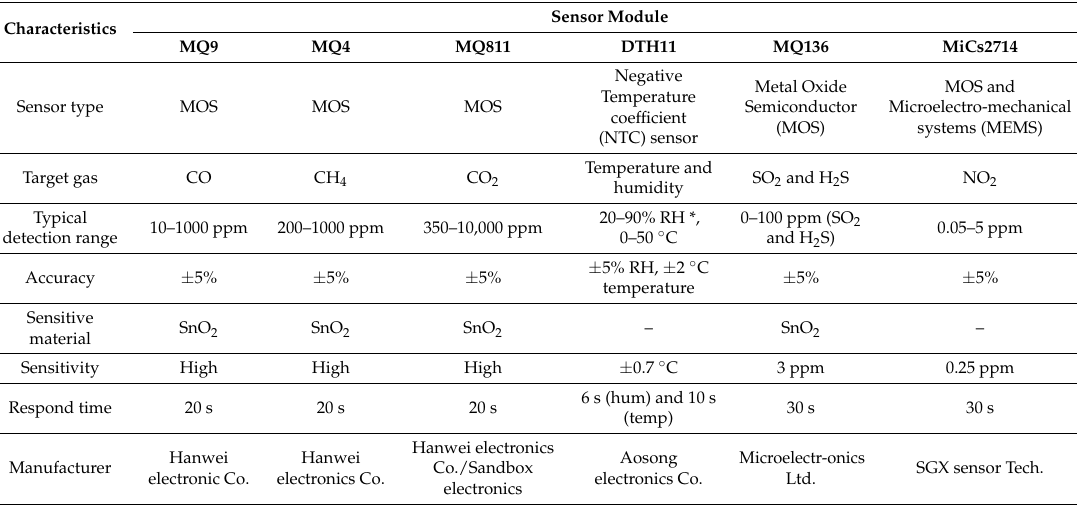
Table 1. Sensors used for experimentation and their characteristics.